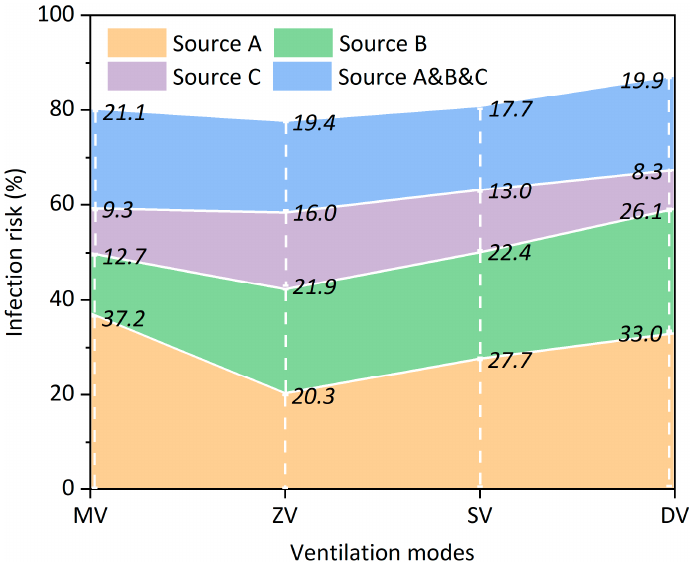
Figure 9. Infection risk (with exposure time of 1 h) under different ventilation modes of MV, ZV, SV and DV and locations of infected source of A, B, C and A and B and C.